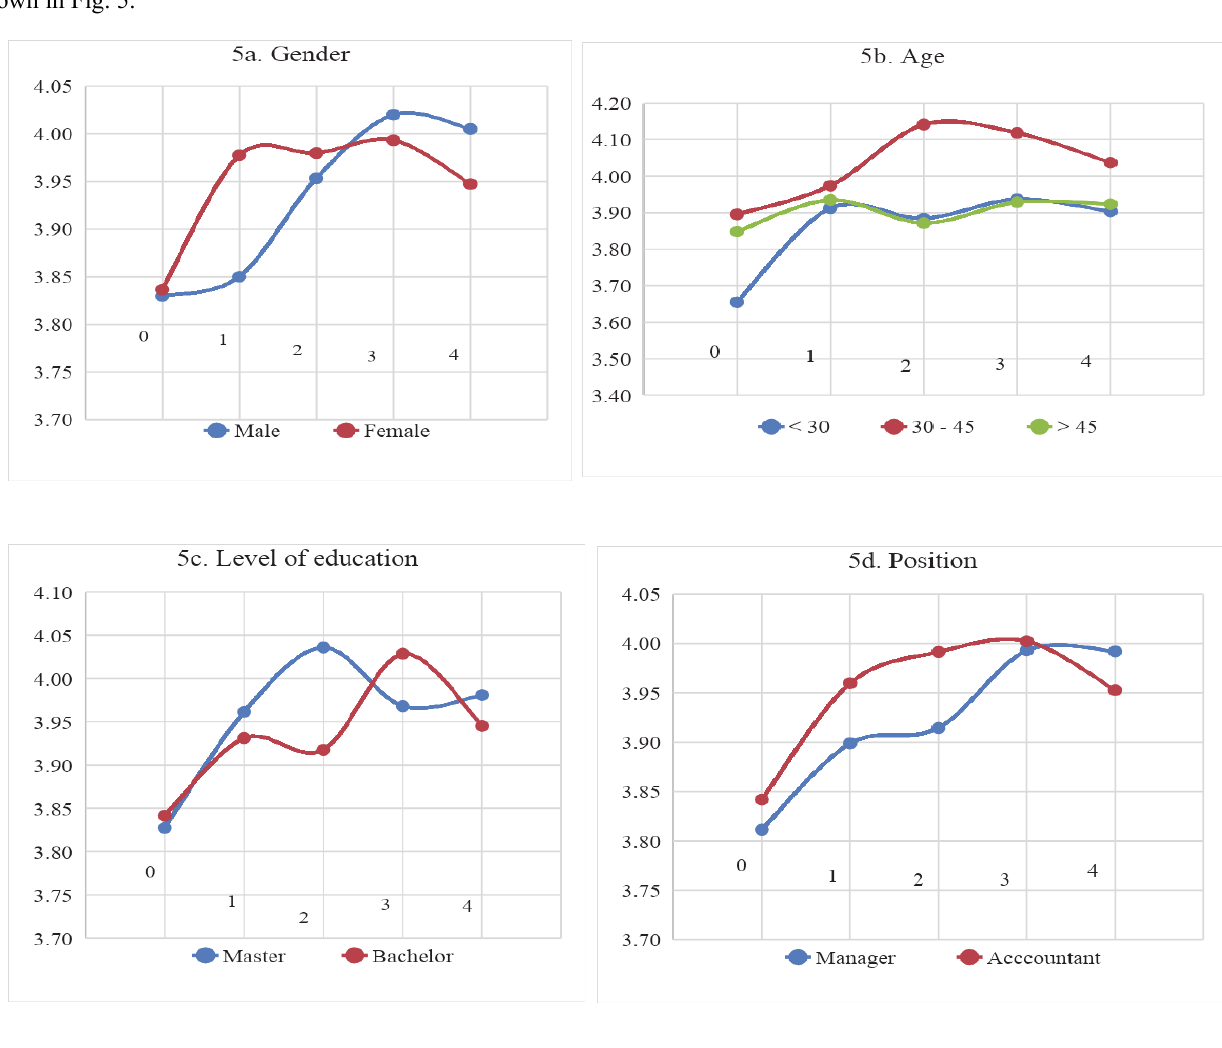
Fig. 5. Demographic